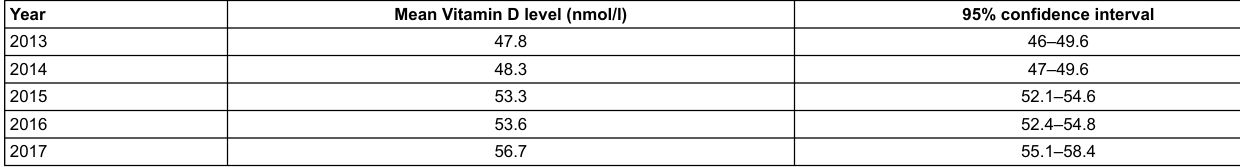
Mean values were adjusted for differences in the distribution of age, gender and season across years. Table 5: Results of multivariable linear regression model of Vitamin D level as a function of subject’s age, sex and year and season of measurement. N =